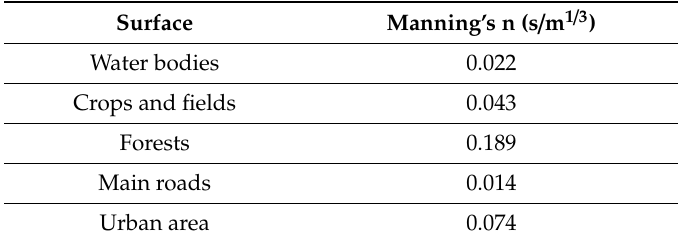
Table 1. Calibrated Manning’s coe ffi cient for the hydrodynamic